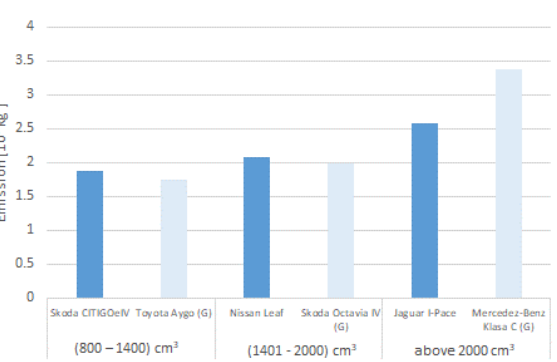
Fig. 6. Comparison of emissions of CO, NO x , PM and SO 2 selecting Fig. 3. Comparison of CO 2 emissions for the selection of cars for testing in vehicles for testing because of the brand of vehicle. G – gasoline, D – terms of engine displacement. BEV – navy blue, ICE – light blue, G – diesel gasoline  type of internal combustion engine (spark-ignition or compression-ignition),  displacement of the internal combustion engine,  energy